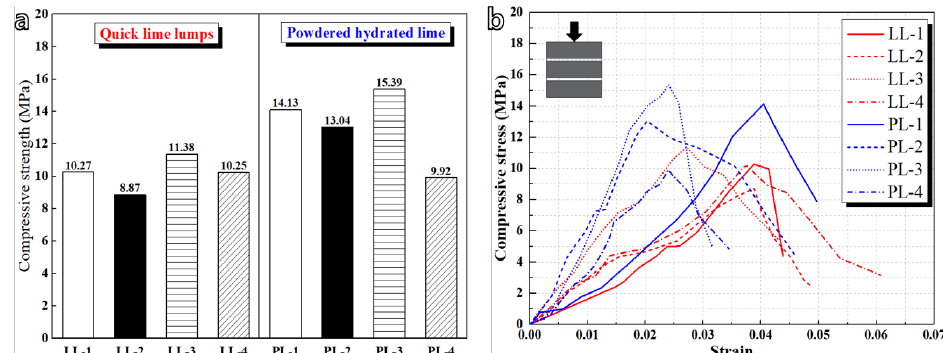
Figure 16. Compressive strength of masonry prism test results. ( a ) Compression strength ( b ) strain– stress